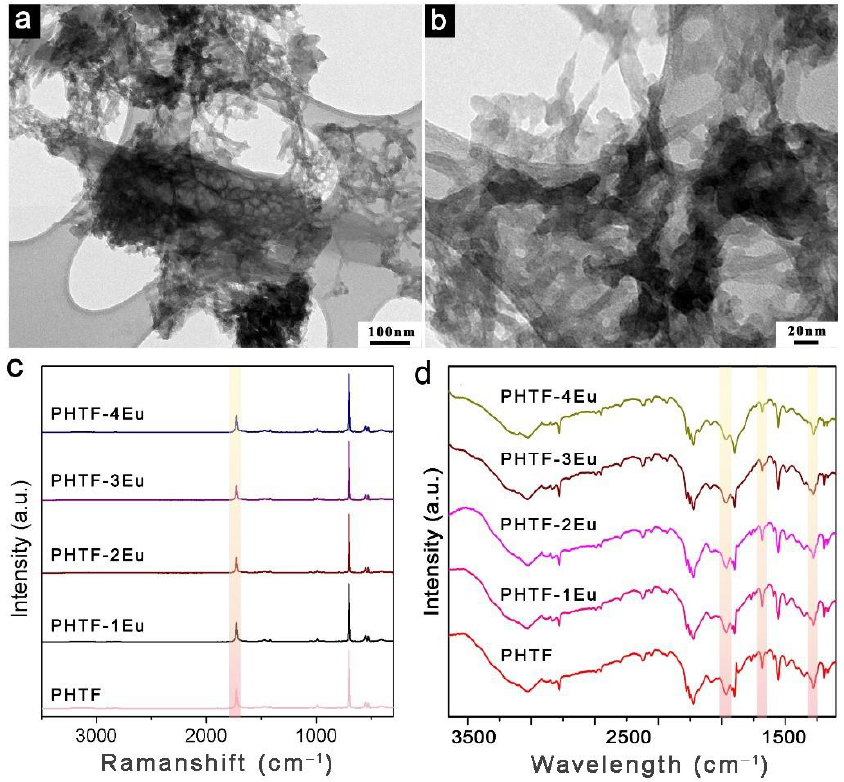
Figure 2. ( a , b ) TEM images of PHTF-2Eu at different magnifications; ( c ) Normalized FT-Raman spectra of PHTF and PHTF:Eu; ( d ) Normalized DRIFTS spectra of PHTF and PHTF:Eu.